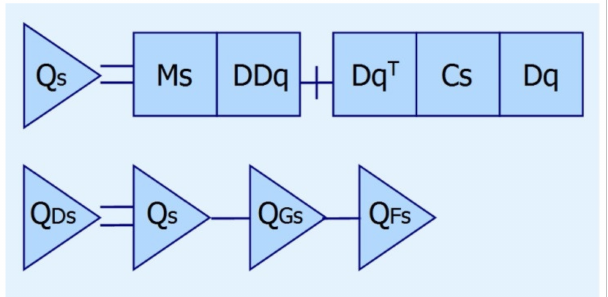
Figure 7. Object diagram of the dynamic model of manipulation systems of robots On the presented object diagram, Qs—the scalar value corresponding to the resulting generalized force along with the s -th generalized (hinge) coordinate; QDs—the scalar value corresponding to the force developed by the drive in the s -th joint (hinge); QGs—the scalar value corresponding to the generalized force Q Gs ; QFs—the scalar value corresponding to the generalized force Q Fs . Ms—the object corresponding to the matrix-string M s ; Cs—the object corresponding to the matrix C s ; Dq, DDq and Dq T —objects that model vectors . T q and ,